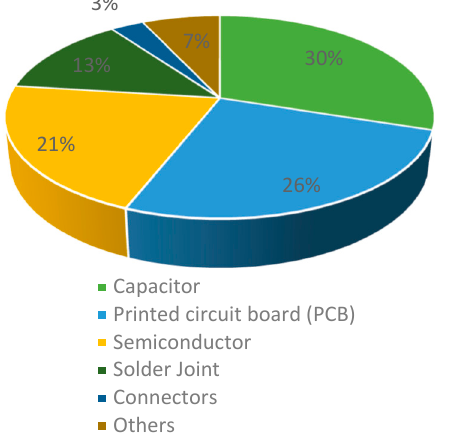
Figure 1. Distributions of faults in power electronic converter components.